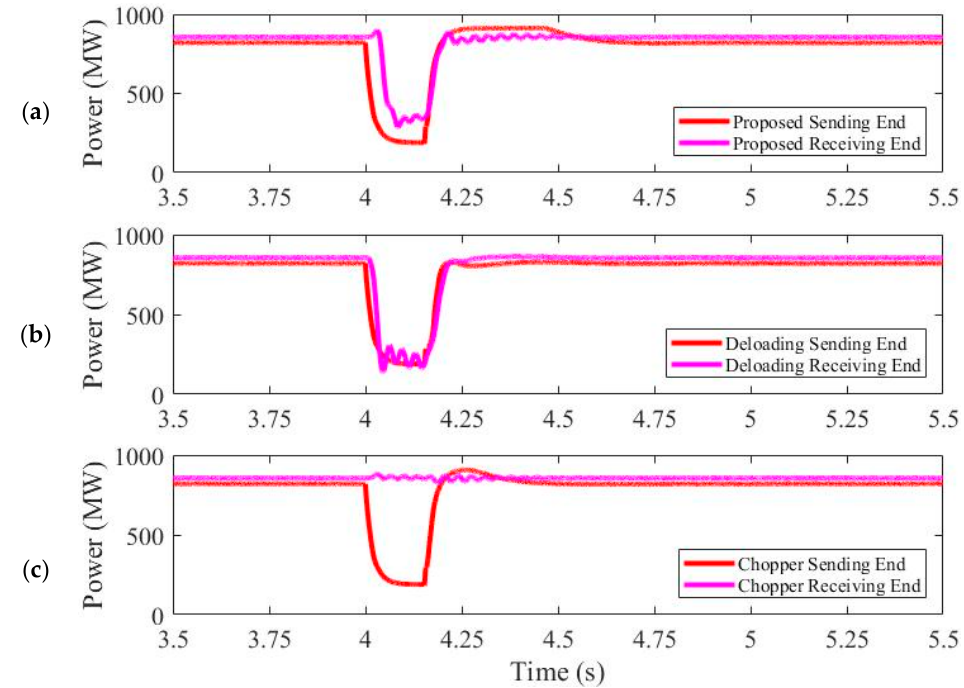
Figure 12. Simulation results of the on-shore fault scenario with a 2.95 Ω fault resistance. ( a ) On-shore and off-shore power with the proposed control strategy case. ( b ) On-shore and off-shore power with the deloading control strategy case. ( c ) On-shore and off-shore power with the DC chopper strategy case.